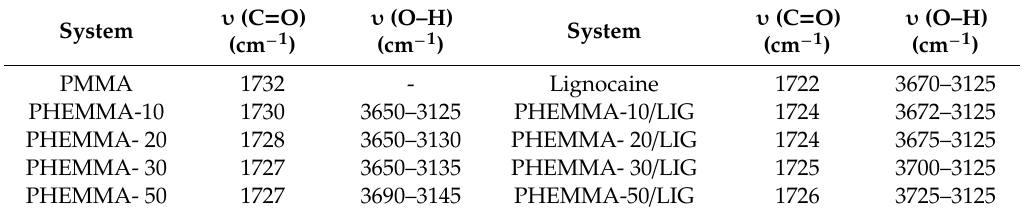
Figure 4. FTIR analysis of PHEMA, PMMA, and PHEMMA with di ff erent MMA contents. Table 5. FTIR absorption bands of carbonyl and hydroxyl groups in PHEMMA, PHEMMA / LIG systems, and their